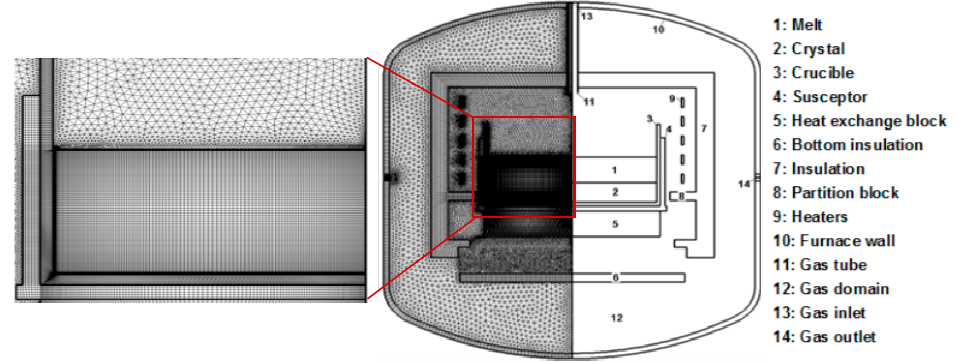
Figure 1. Configuration and computational grids of an industrial seeded DS (directional solidifica- tion) furnace.